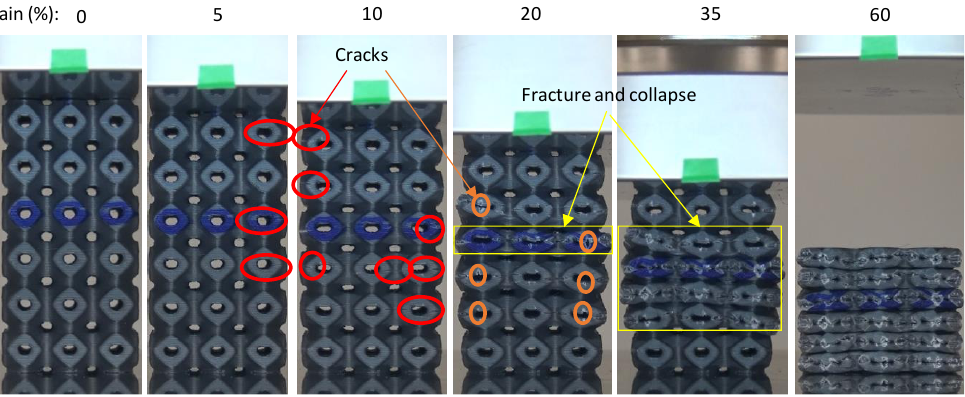
Figure 12. Typical deformation evolution of Primitive structure (P-8-44).